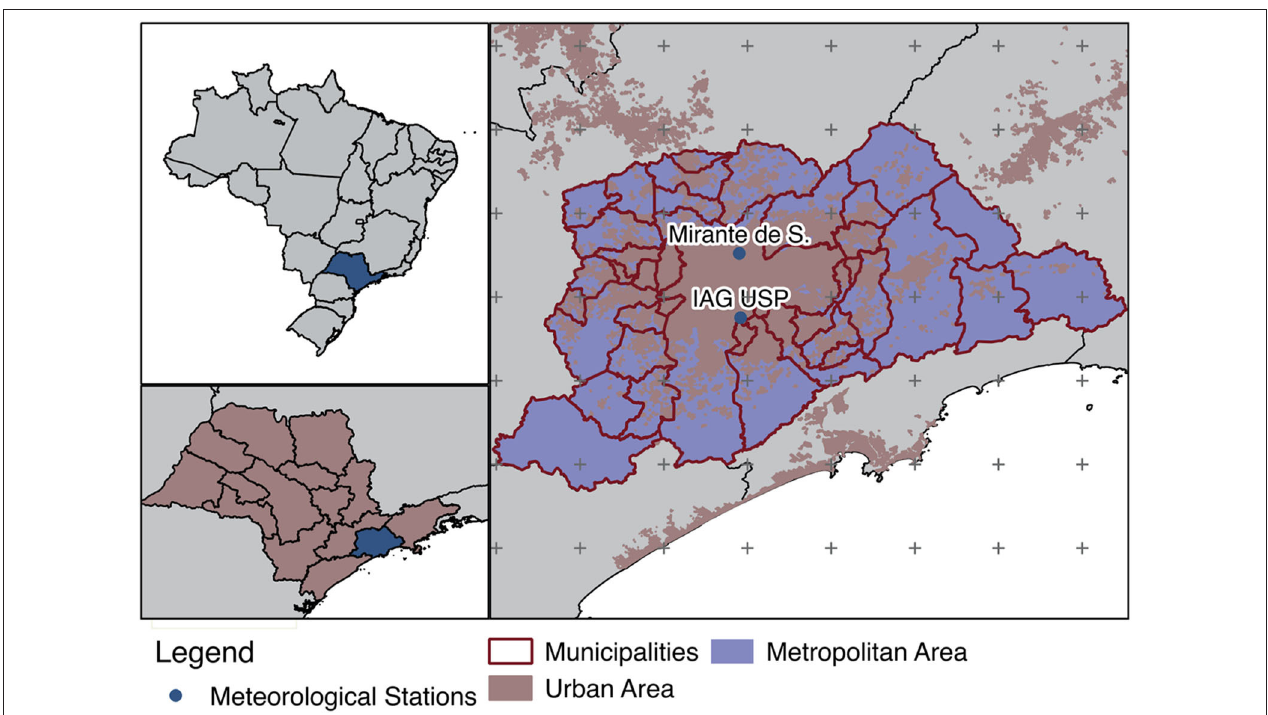
FIGURE 1 | Location of the Metropolitan Area of São Paulo (in red) in the state of São Paulo. Location of the two meteorological stations used of this study in the MASP region are shown by blue dots.